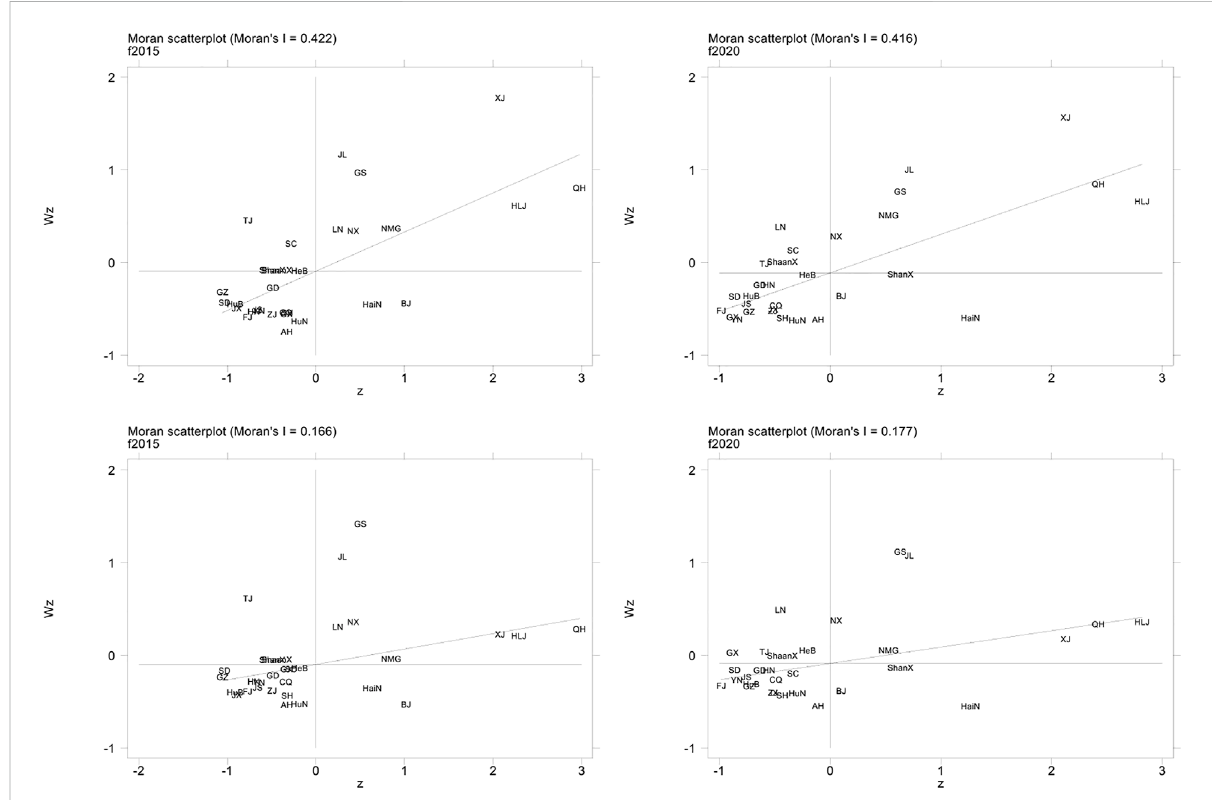
FIGURE 2 Moran scatter plot of proximity matrix and geographic distance matrix in 2015 and